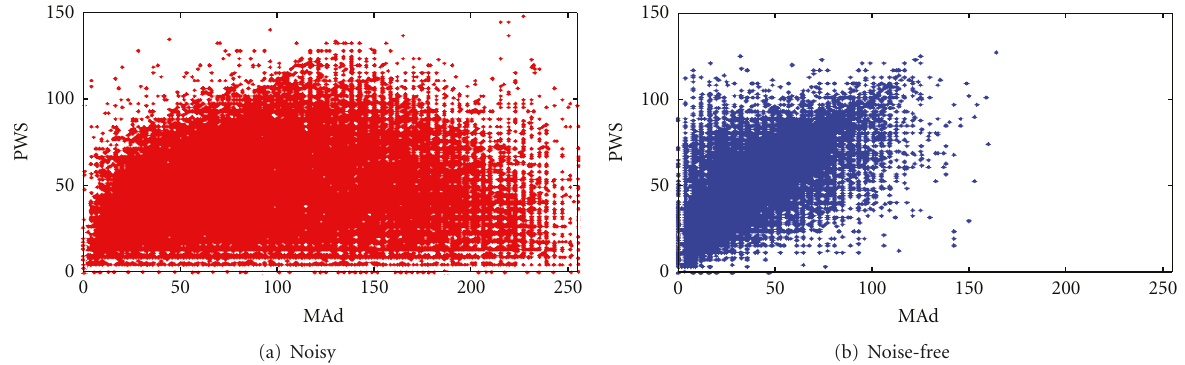
Figure 3: PWS-MAD scatter plots of noisy and noise-free pixels for the image Bridge corrupted with 40% of mixed impulse noise.